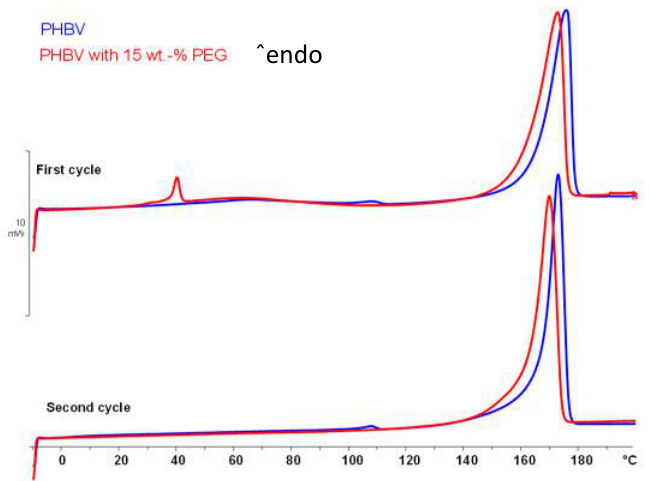
Figure 5. First and second heating cycle of a differential scanning calorimetry (DSC) measurement.